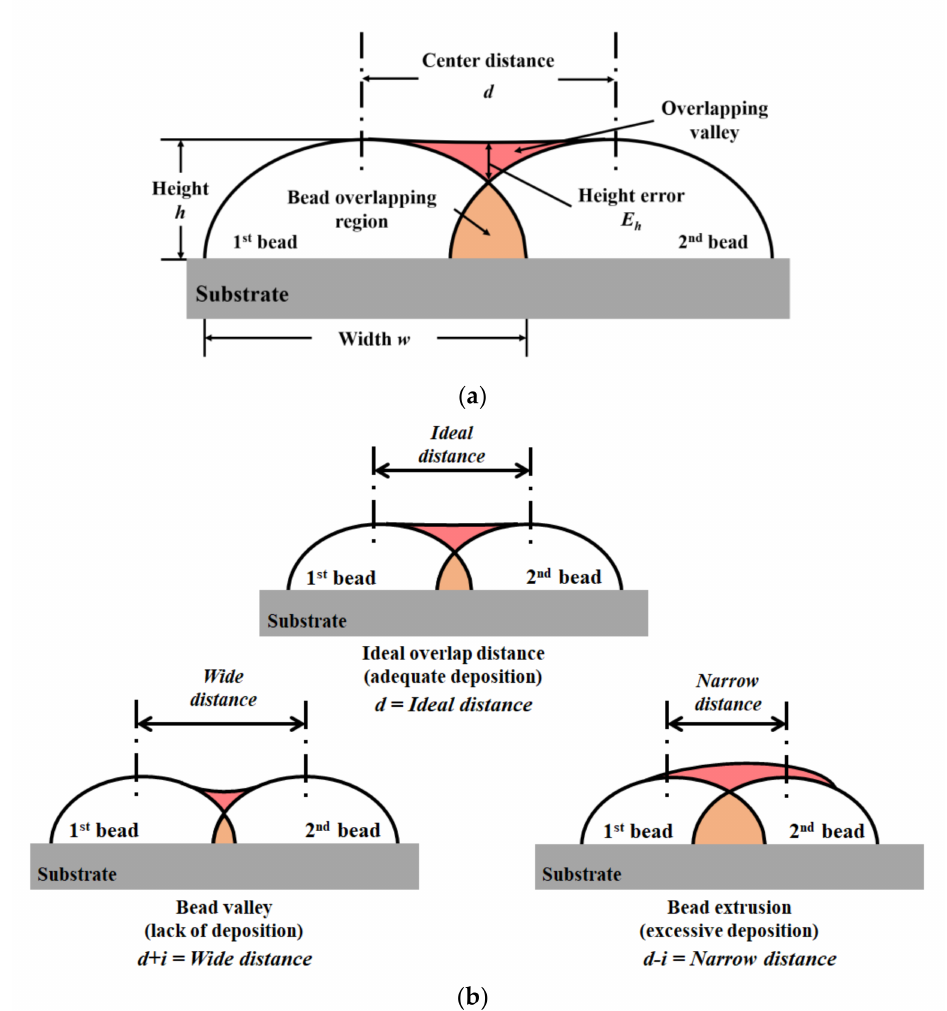
Figure 3. Schematic diagram of the overlapping bead modeling: ( a ) the overlapping model, ( b ) the overlapping model considering height